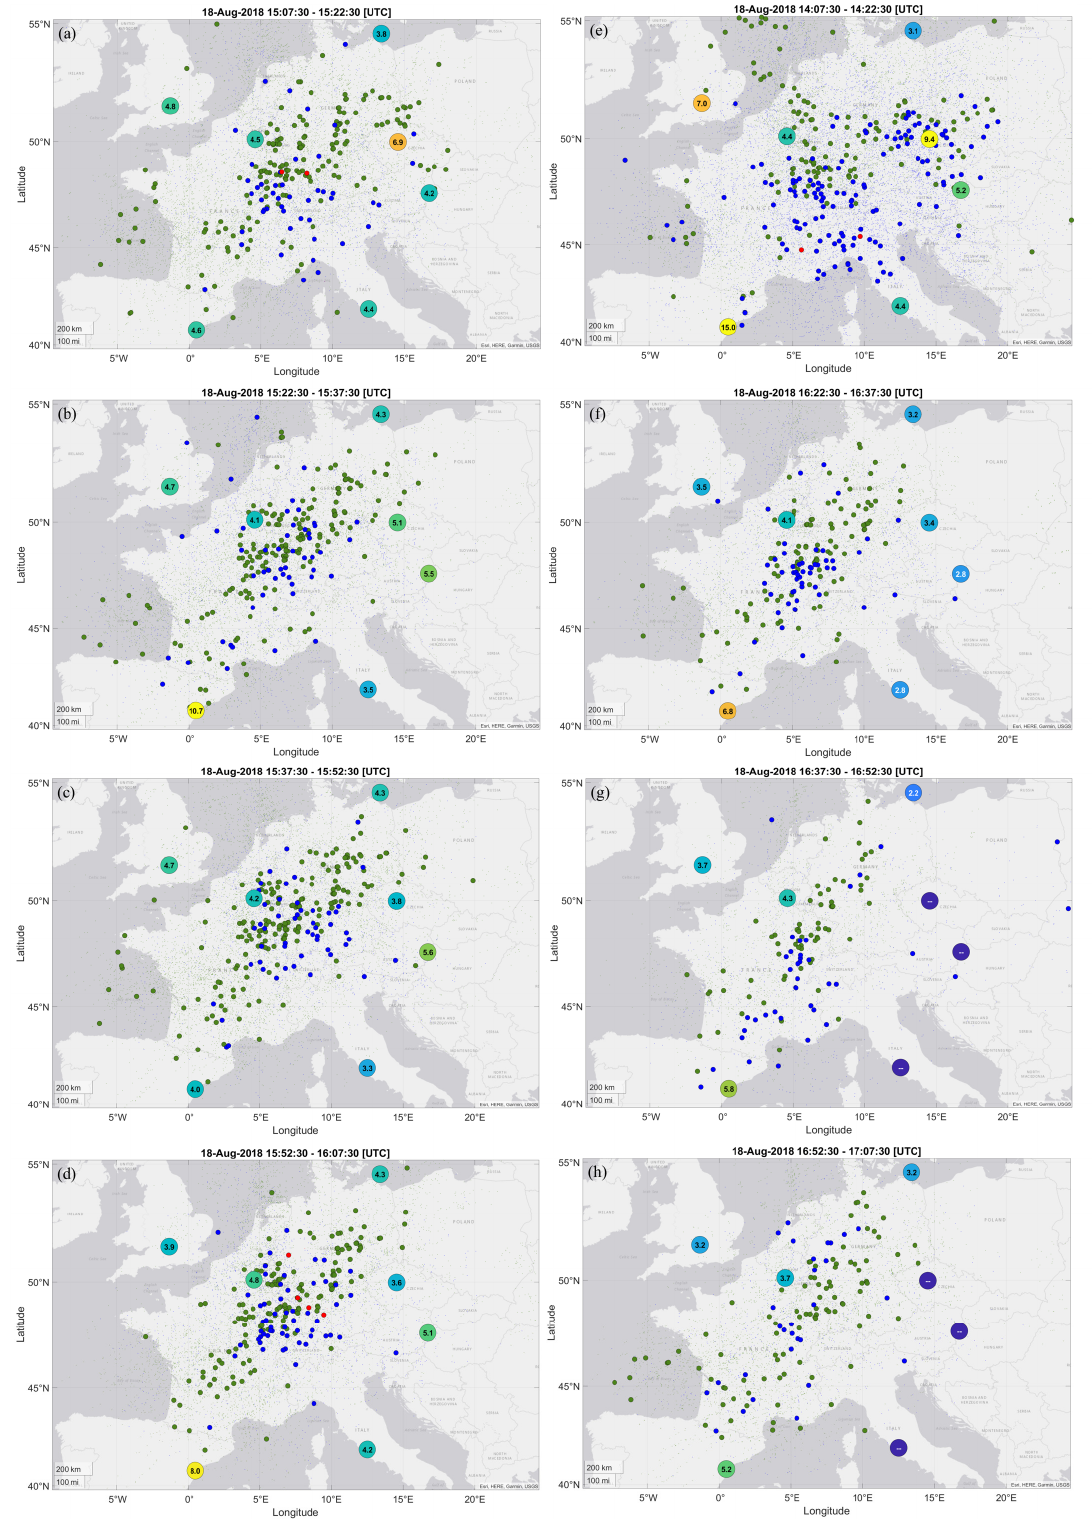
Figure 9. ( a – h ). Second part of sporadic E event 18 August 2018, sequential 15 min samples centered from 15:15 UTC to 17:00 UTC. Large circles: ionosonde-derived f t Es [MHz] (dark = low, pale = high, -- = no Es). Medium circles: approximate signal reflection points (green = 28 MHz, blue = 50 MHz, red = 70 MHz). Dots: estimated coverage (colors ditto).